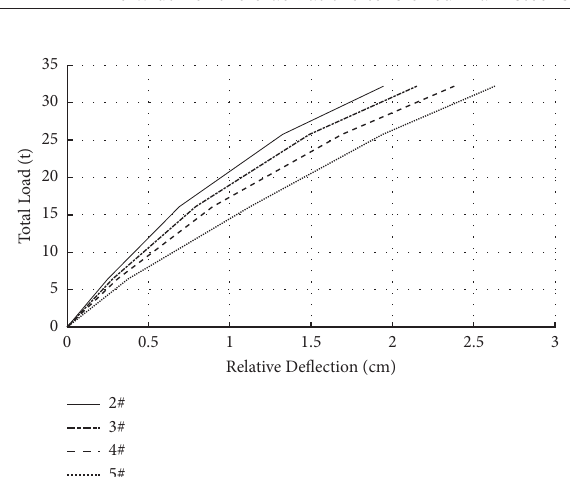
Figure 9: Midspan deflection-load curve of normal loading.